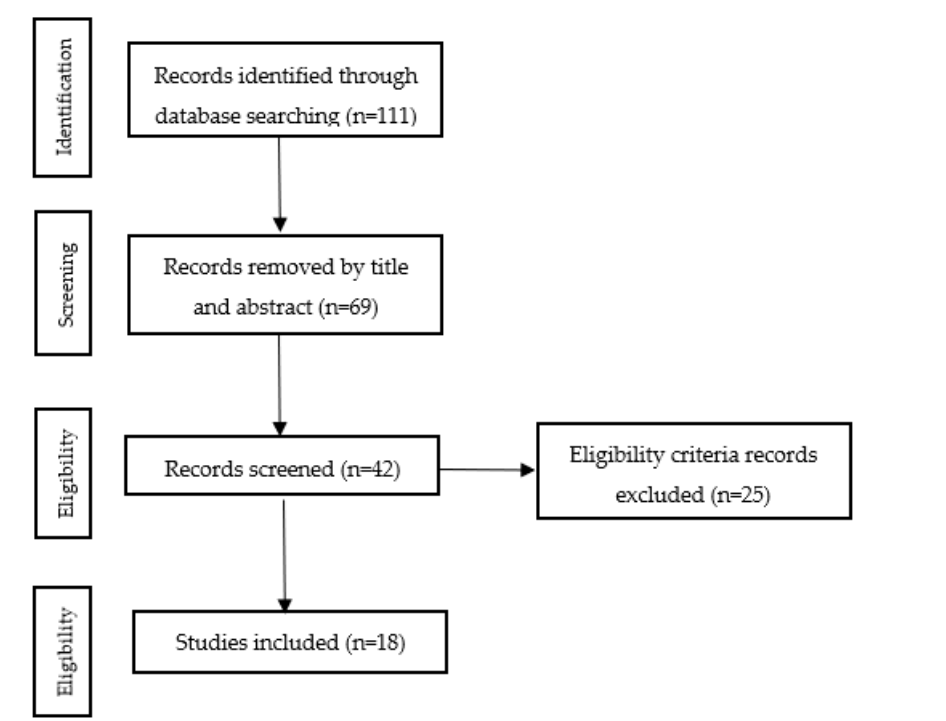
Figure 1. The PRISMA flowchart illustrating each stage of the literature search.